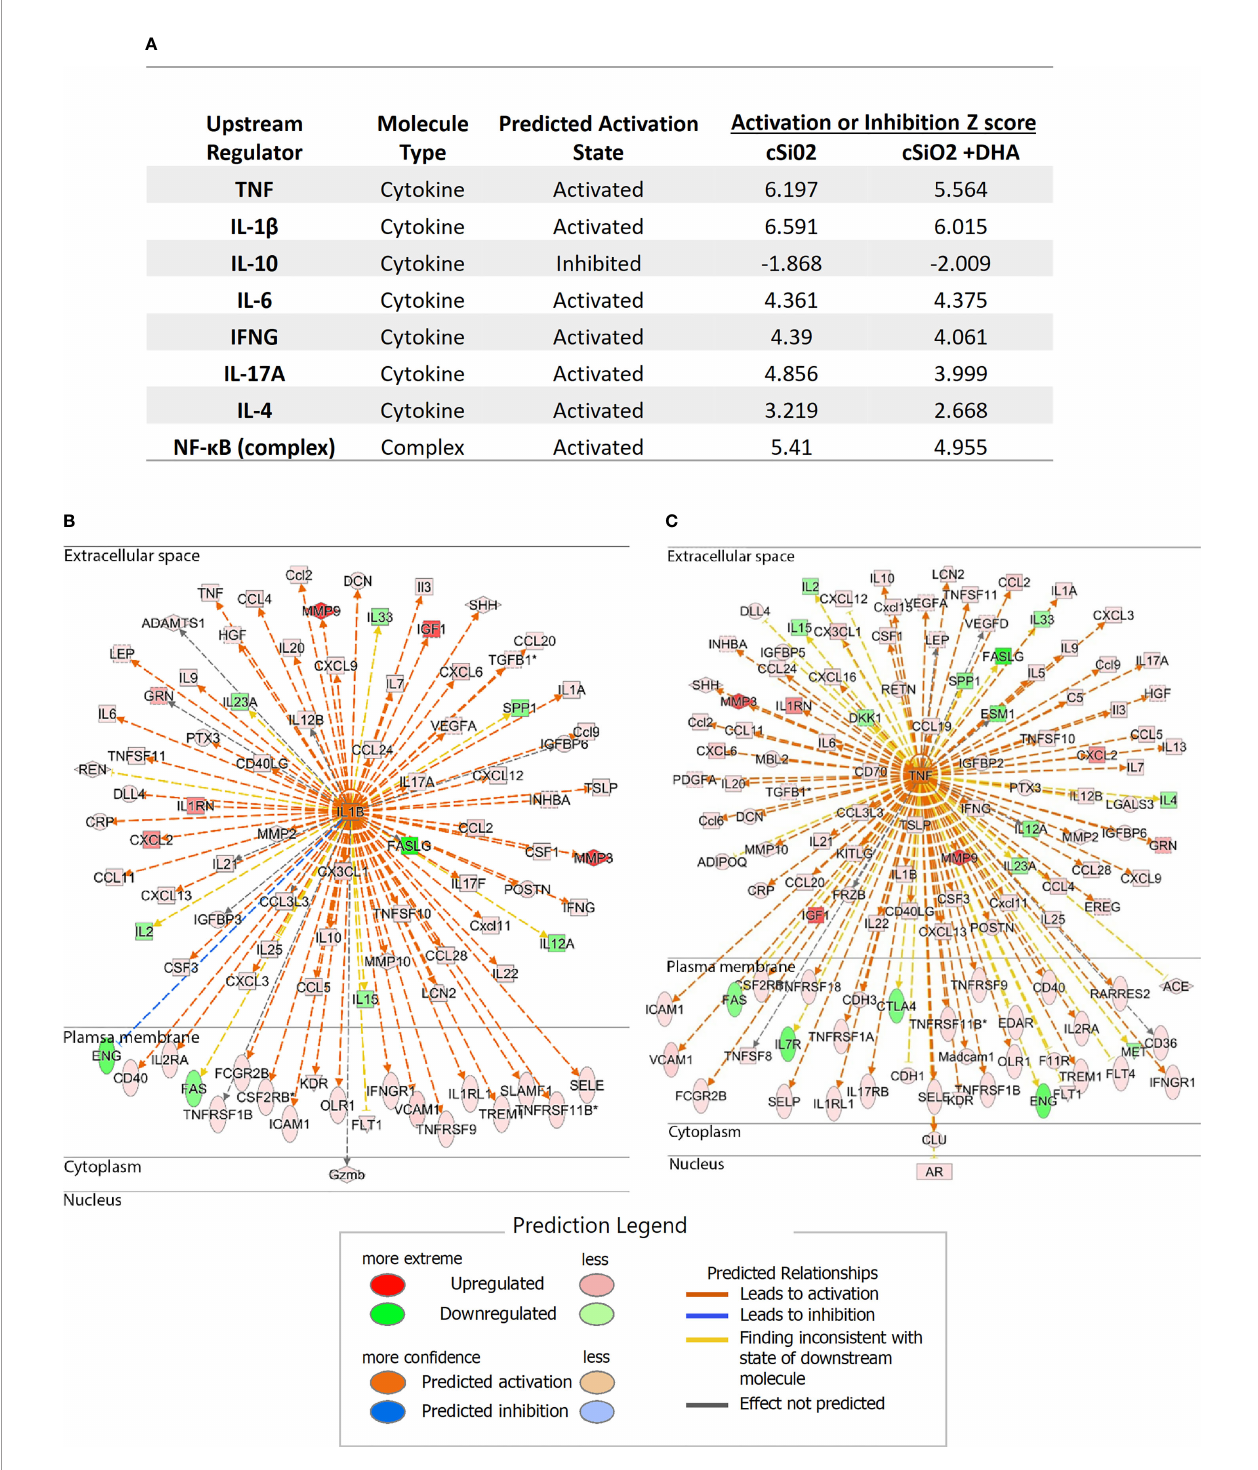
FIGURE 9 | DHA supplementation negatively in fl uences major upstream regulators of cSiO 2 -induced in fl ammatory protein expression. (A) Top upstream regulators present in cSiO 2 /CON and cSiO 2 /DHA treatments in BALF were predicted by IPA. Positive Z-score indicates activation, and negative Z-score indicates inhibition. Targets of (B) IL-1 b and (C) TNF- a present in data set. Up-regulated and down-regulated proteins are highlighted in red and green, respectively, and the color depth is correlated to the fold change. Orange and blue dashed lines with arrows indicate indirect activation and inhibition, respectively. Yellow and gray dashed lines with arrows depict inconsistent effects and no prediction,